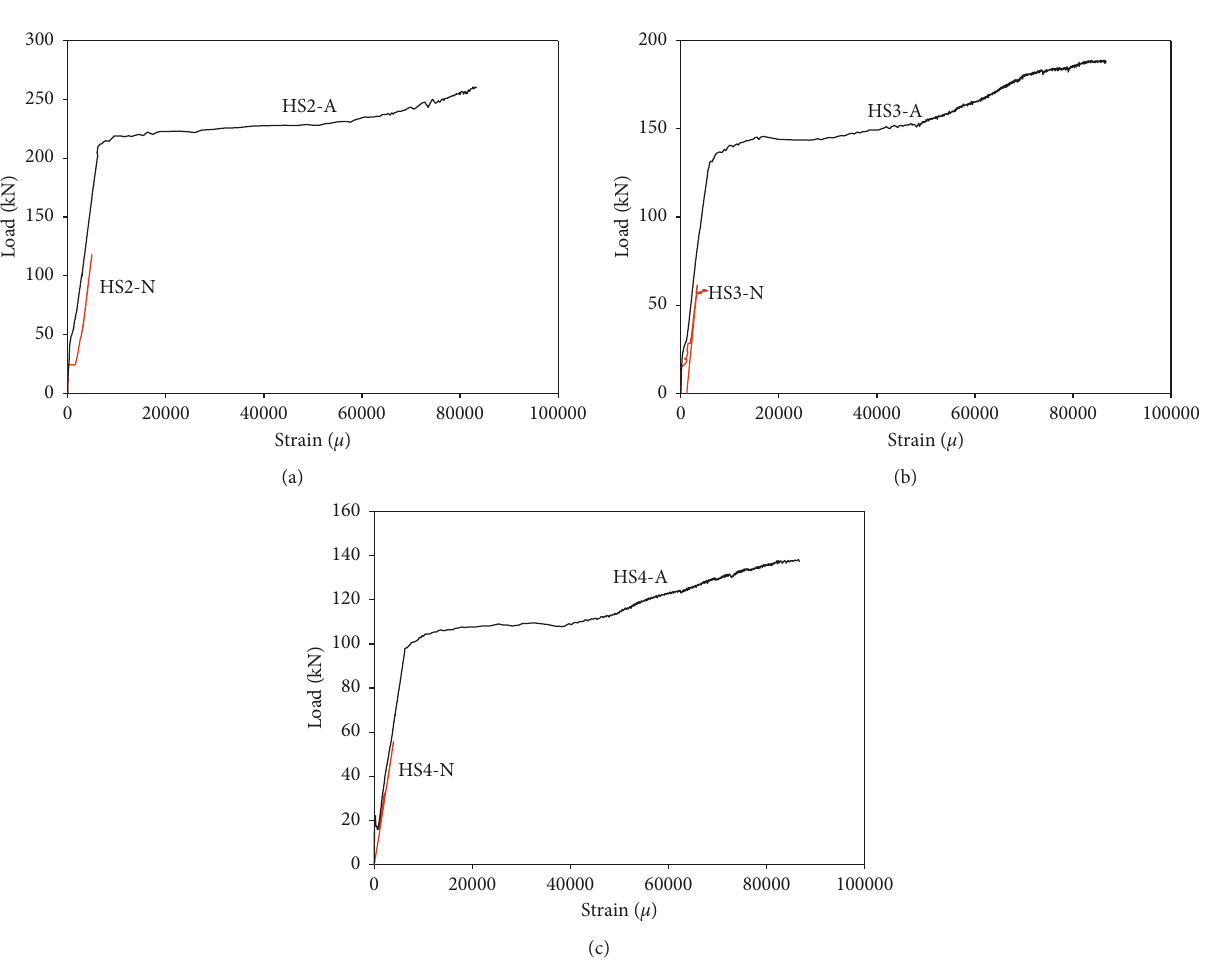
Figure 12: Load-steel strain curve of UHPC shear